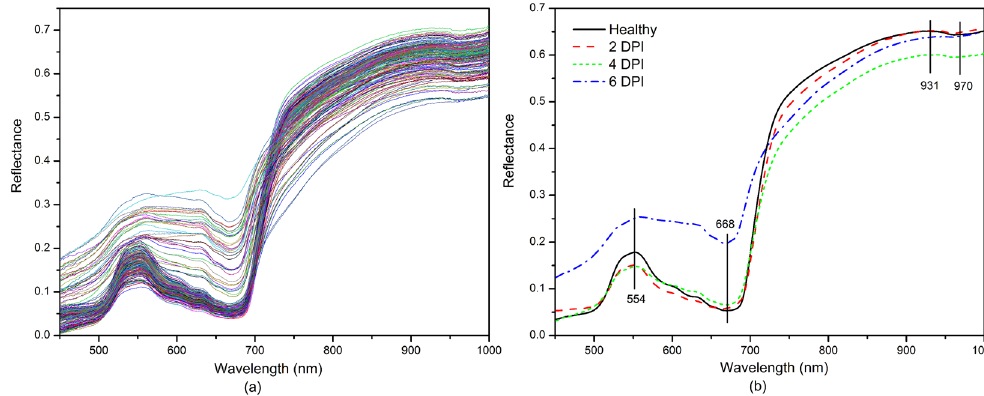
Figure 1. ( a ) Raw spectra (450–1000 nm) of tobacco leaves samples; ( b ) The average reflectance spectra of ‘Healthy’, ‘2 DPI’, ‘4 DPI’, and ‘6 DPI’ tobacco leaves at 450–1000